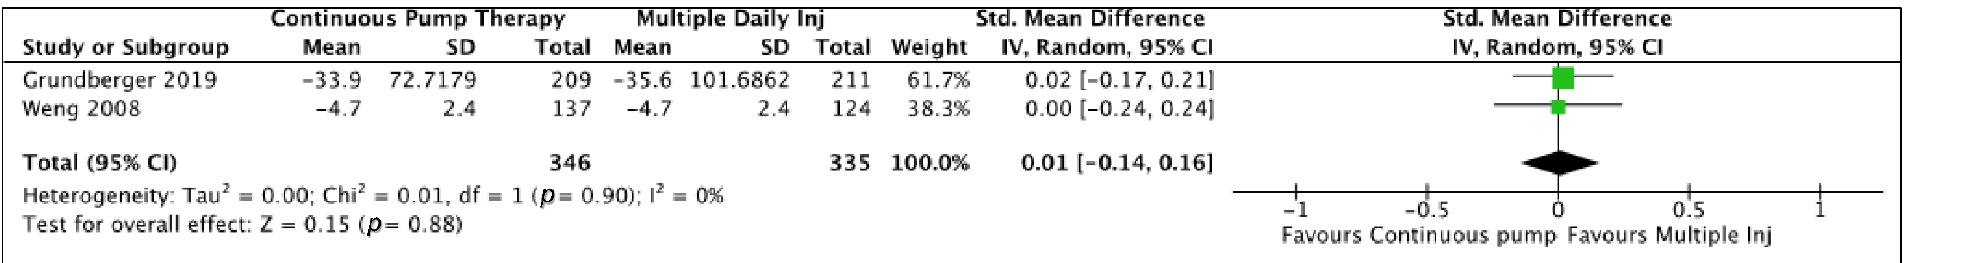
Figure 5. Meta-analysis results and Forest plot for Fasting Plasma Glucose.